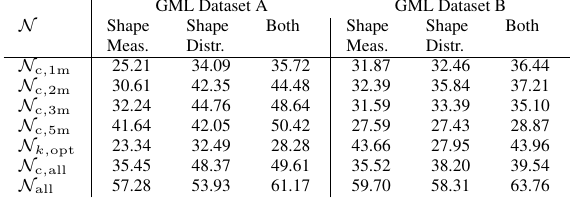
Table 2. C κ (in %) for different neighbourhood definitions and different feature sets.